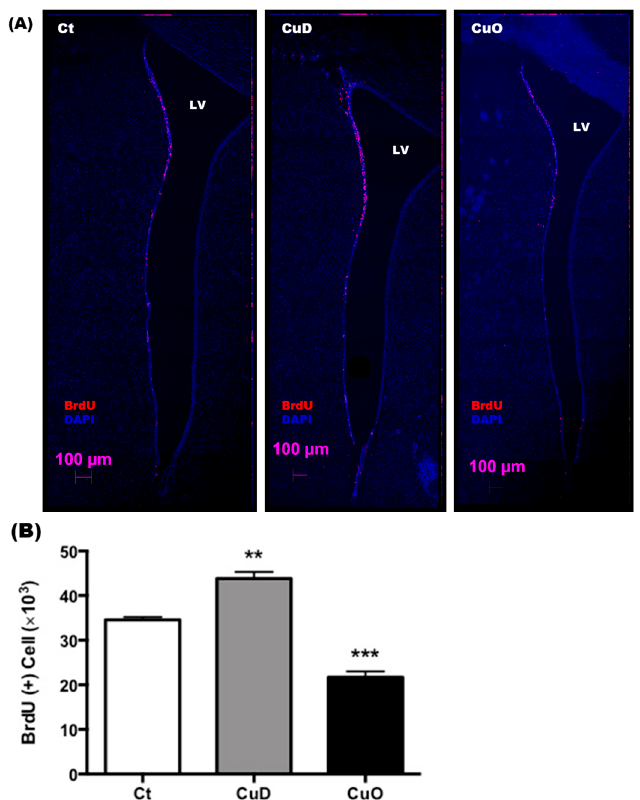
Figure 5. Confocal imaging study of proliferating NPSCs in the SVZ following CuD or CuO treatment. ( A ). Representative confocal images of the left coronal SVZ with BrdU (red signal)/DAPI (blue signal) staining. Scale bar = 250 μ m. ( B ). BrdU(+) cell counts in the SVZ. Data represent mean ± SEM, n = 3–4/group. **: p < 0.01, ***: p < 0.001, as compared with the correspondent Ct group; using one-way ANOVA analysis.